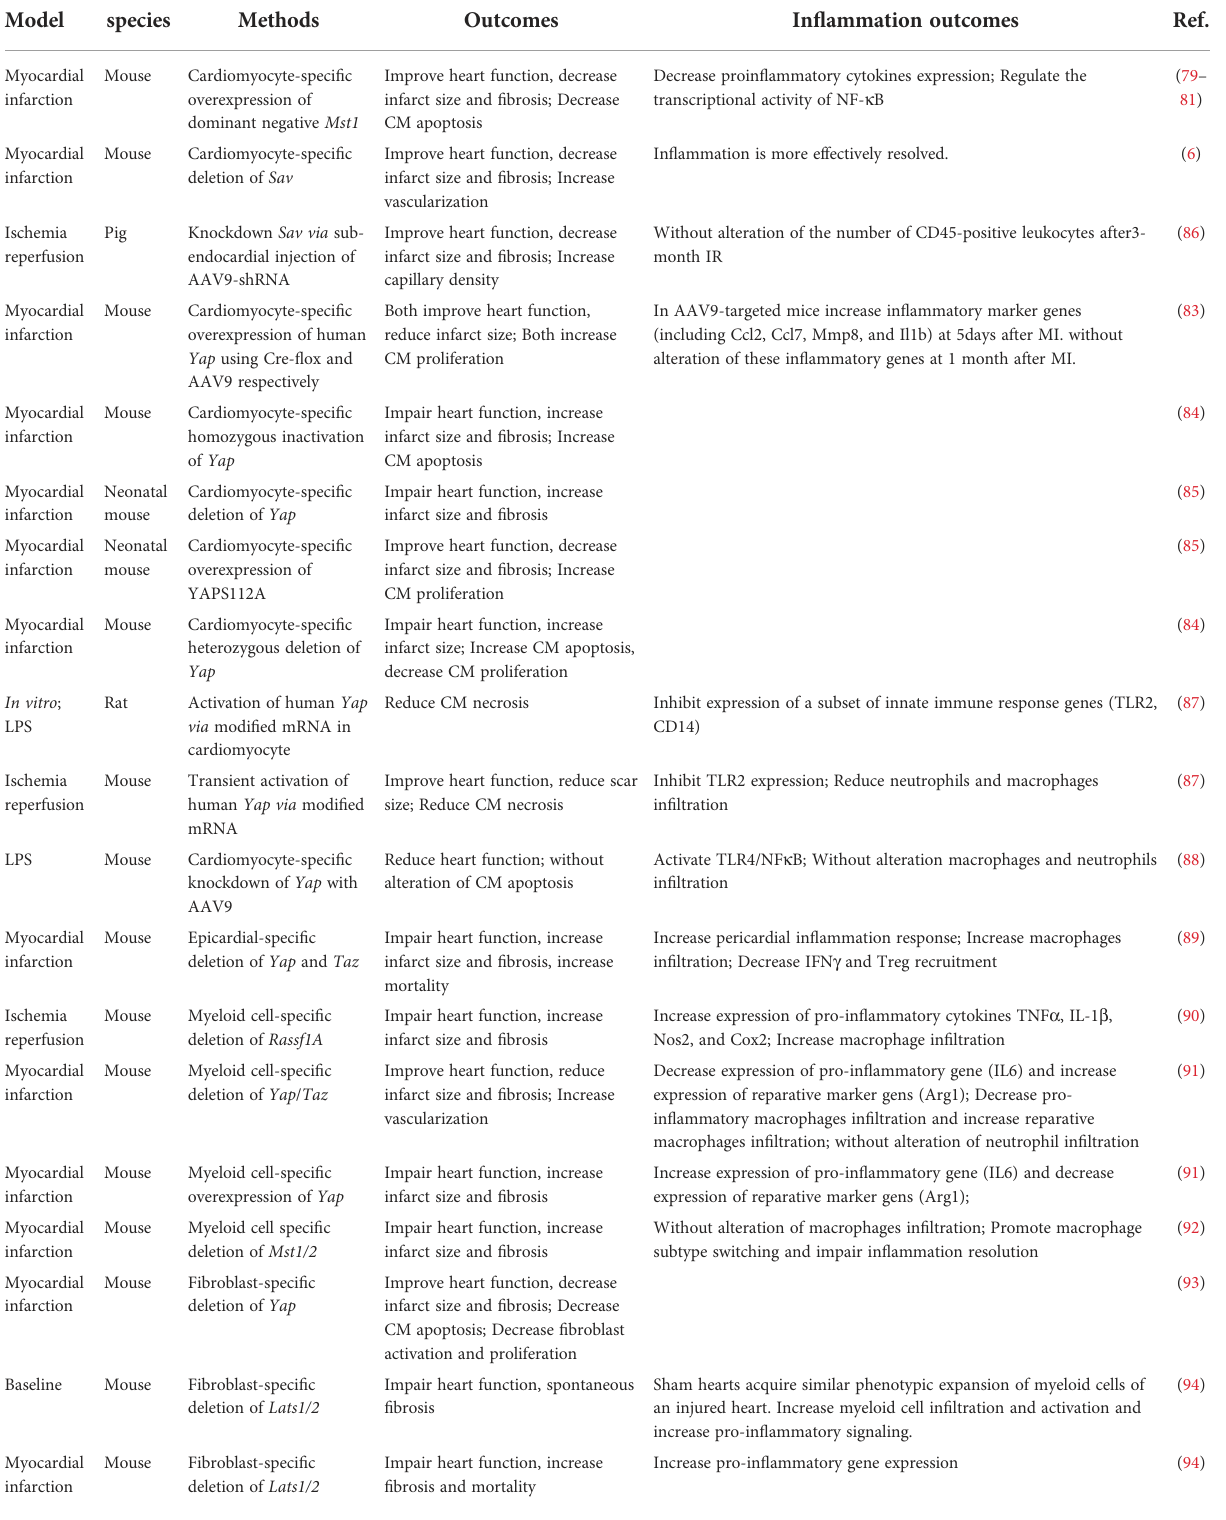
TABLE 1 Hippo-YAP pathway and in fl ammation in myocardial infarction.